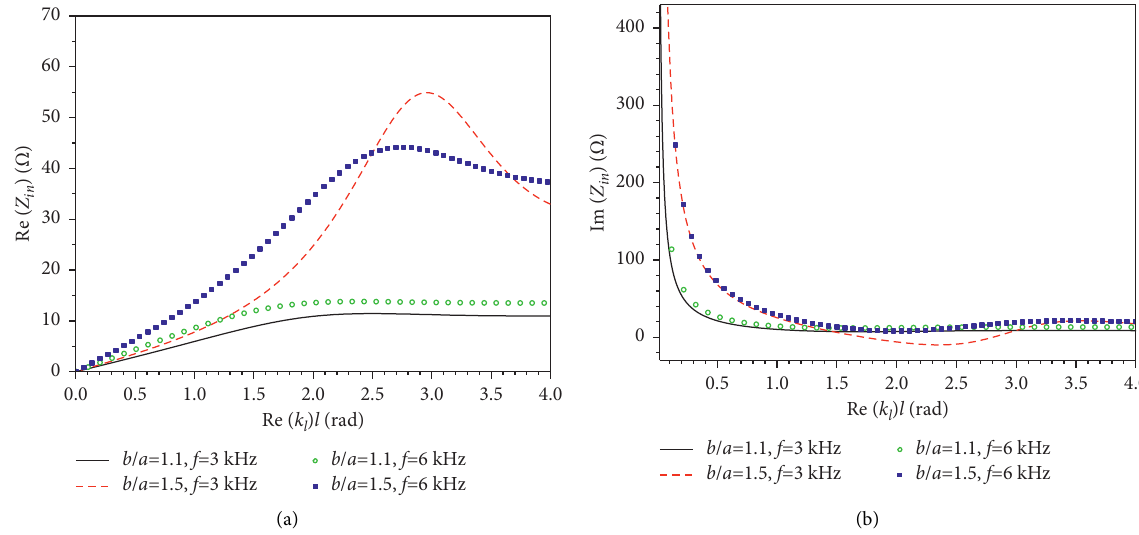
Figure 4: Input impedance of an insulted antenna in an anisotropic ionosphere for various insulation thicknesses and working frequency. (a) Input resistance and (b) input